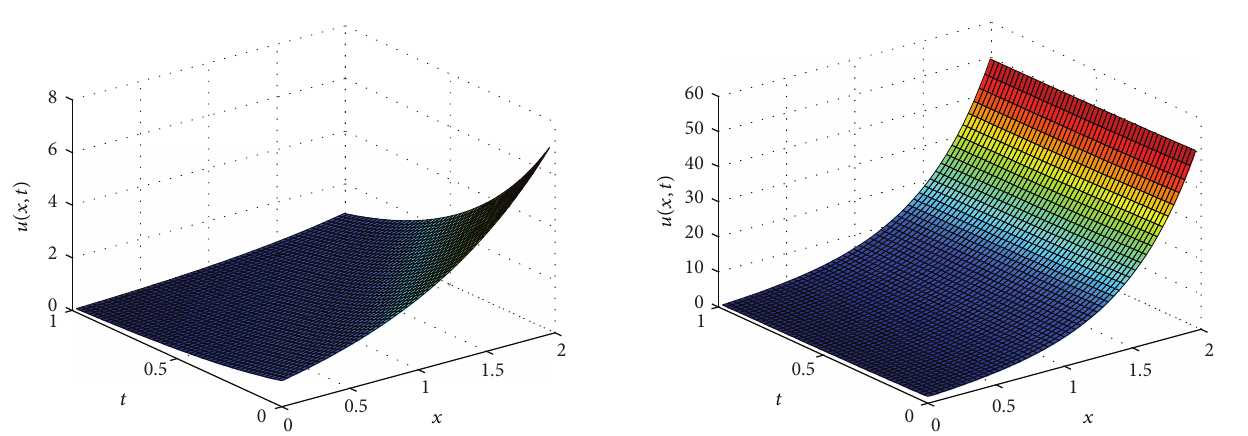
Figure 6: Plot of 𝑢(𝑥,𝑡) with respect to 𝑡 , 𝑡 ∈ [0,1] at 𝑥 = 2 for Example 2.